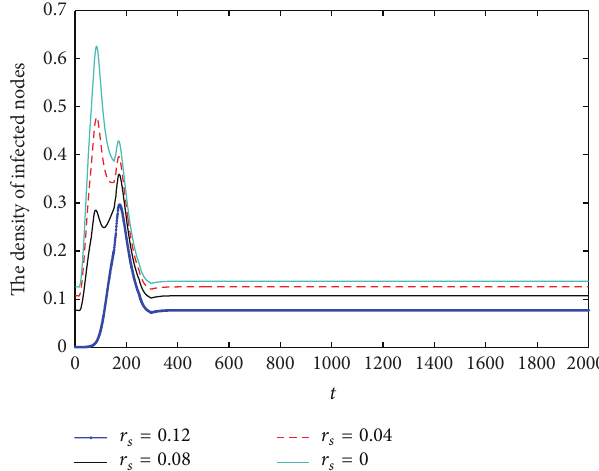
⟨𝑘⟩ = 8 , and 𝑐 , Figure 5: An illustration of the impact of real-time immune measure ( 𝑟 𝑠 ) on the density of infected nodes.